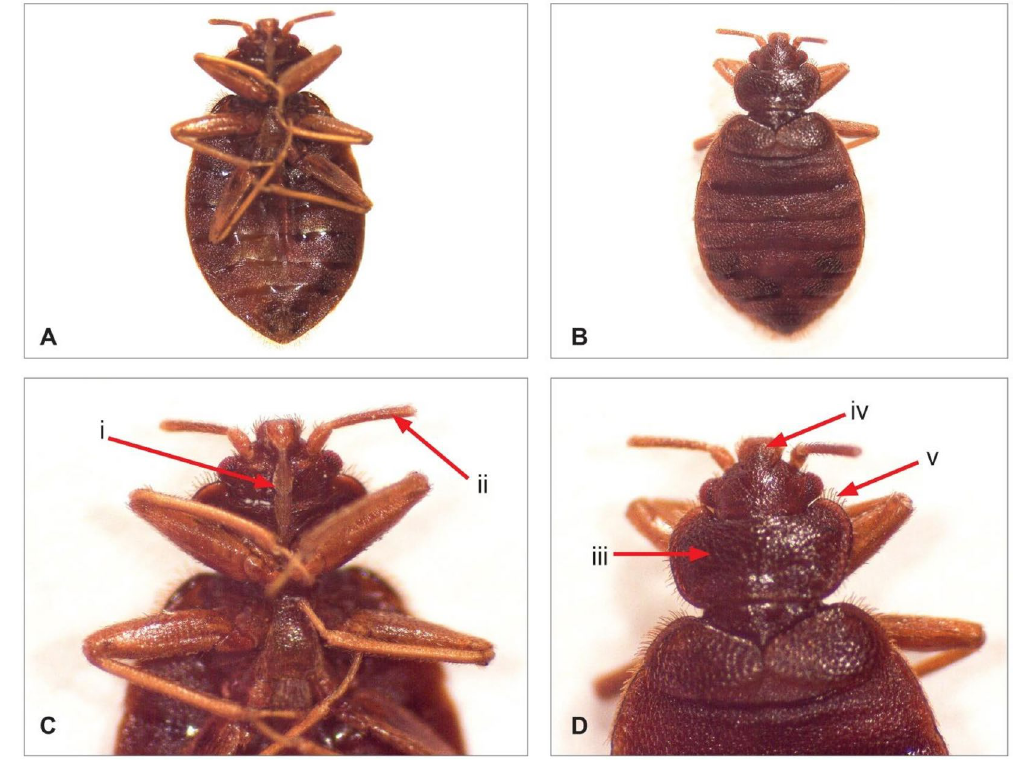
Figure 1. Morphological features of bedbug: ( A ) ventral side, ( B ) dorsal side, ( C ) ventral head section; (i) proboscis; (ii) antenna, ( D ) dorsal thoracic section; (iii) pronotum; (iv) Labrum; (v) fine